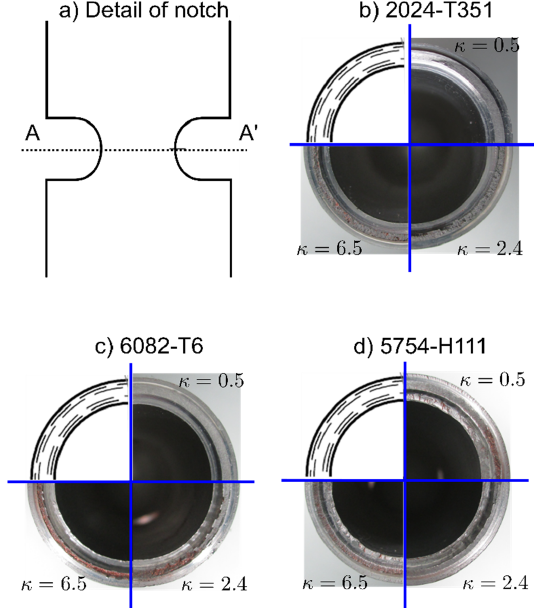
Figure 5. Experimental results. The final stage of the tension–torsion process for different loading conditions. ( a ) Detail of the notch, ( b ) AA 2024 ‐ T351, ( c ) AA 6082 ‐ T6, and ( d ) AA 5754 ‐ H111.